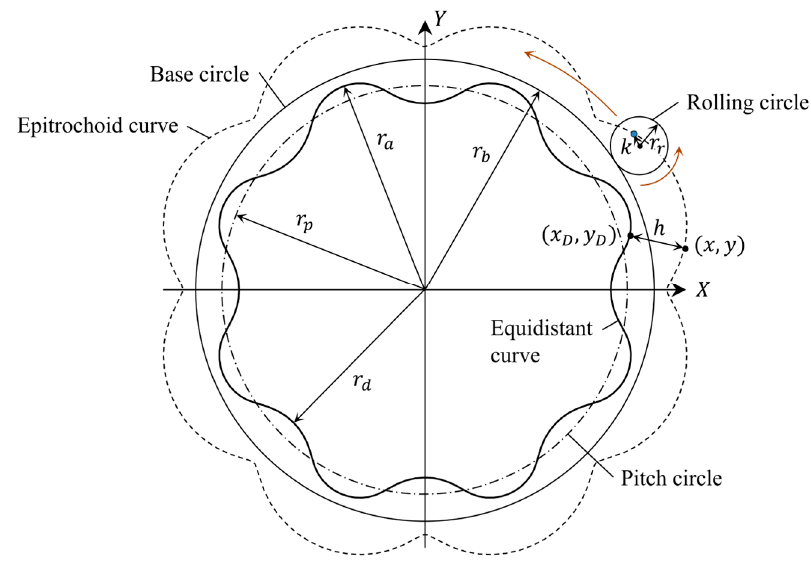
Figure 2. Cycloidal curve generating.